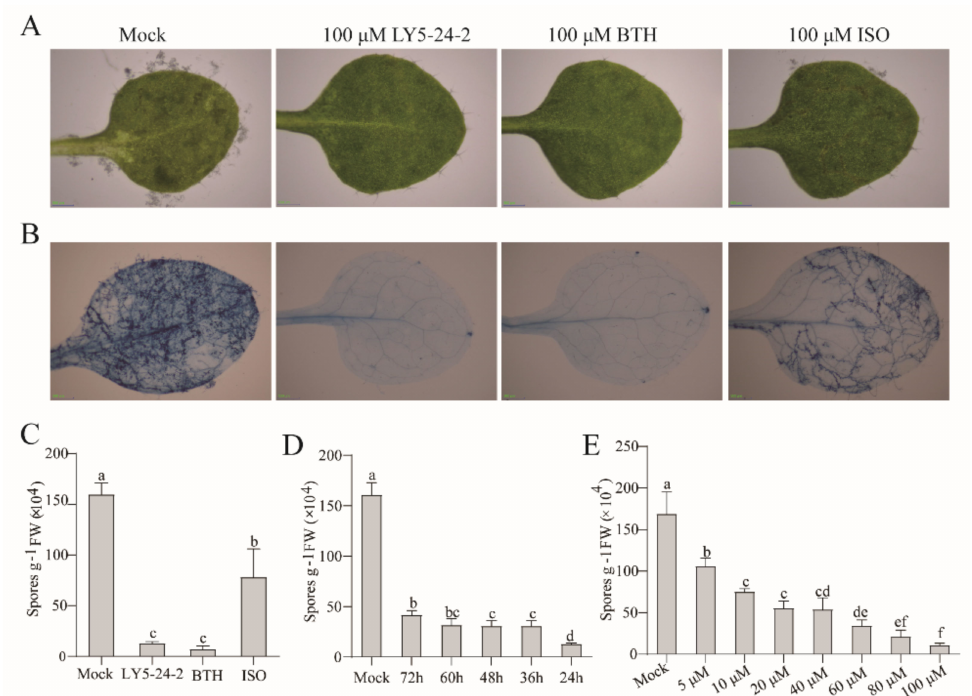
Figure 2. LY5-24-2 enhanced resistance of A. thaliana against H. arabidopsidis Noco2. ( A ) Phenotypes of leaves of wild-type (WT) A. thaliana inoculated with H. arabidopsidis Noco2 at 24 h after a treatment with 100 µ M of LY5-24-2, BTH or ISO. Leaves were harvested at 7 days post inoculation (dpi), Bars, 500 µ m. ( B ) Photographed and stained with lactophenol trypan blue (TB). Bars, 500 µ m. ( C ) Sporulation level of H. arabidopsidis Noco2 of WT, spraying-inoculated with H. arabidopsidis Noco2 at 24 h after a treatment with 100 µ M of LY5-24-2, BTH or ISO. ( D ) Sporulation level of H. arabidopsidis Noco2 of WT, spraying-inoculated with H. arabidopsidis Noco2 at 24, 36, 48, 60 and 72 h after a treatment with 100 µ M of LY5-24-2. ( E ) Sporulation level of H. arabidopsidis Noco2 of WT, spraying- inoculated with H. arabidopsidis Noco2 at 24 h after a treatment with 5, 10, 20, 40, 50, 80 or 100 µ M of LY5-24-2. Seedlings were harvested at 7 days post inoculation (dpi), and spores were counted. Data are shown as the mean of three biological replicates ± SD. The letters represent significant difference ( p < 0.05, Student’s t